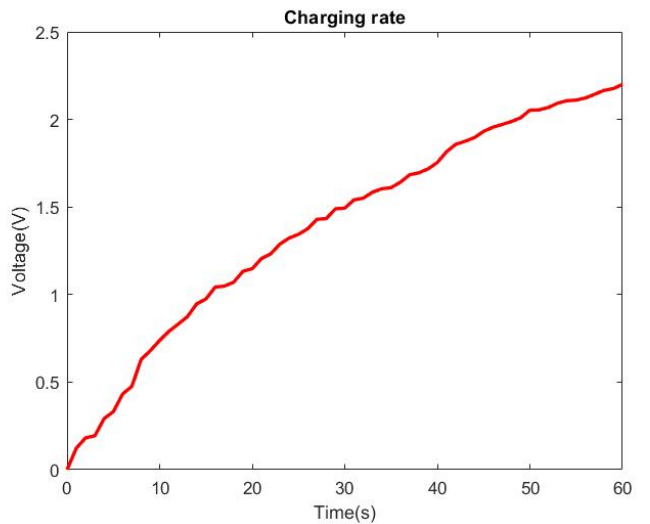
Figure 9. The charging curves of the 47 μ F capacitor with the HDR-TENG. The specification of the HDR-TENG: h is 1.3 mm, the rotation speed is 12,800 rpm with a 25 cm wire length, and the load resistance is 10 M Ω .